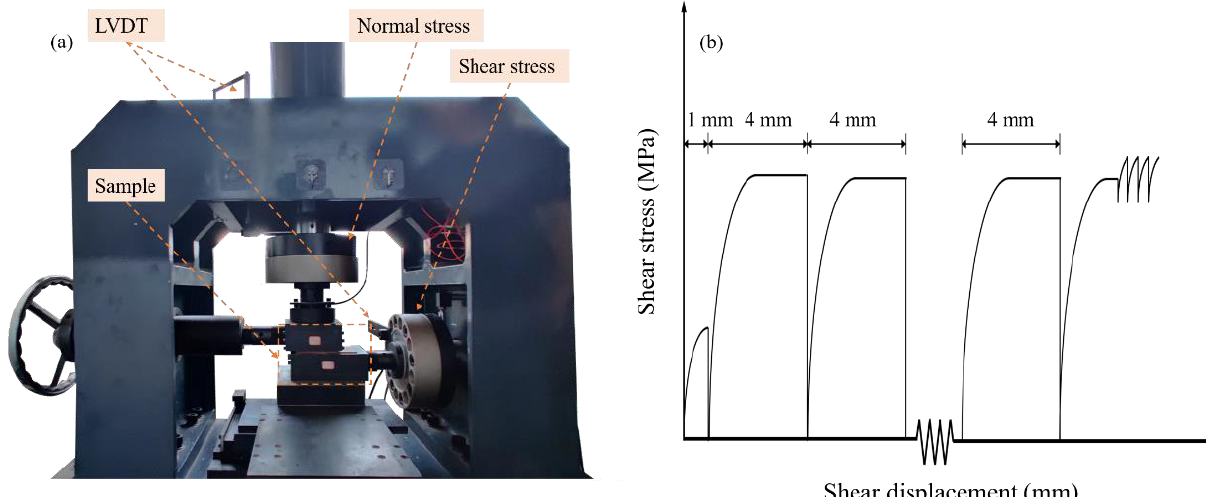
Figure 2. Fault block slip experiment. ( a ) Shear test apparatus (LVDT: Linear Variable Displacement Transducer). ( b ) Schematic diagram of loading